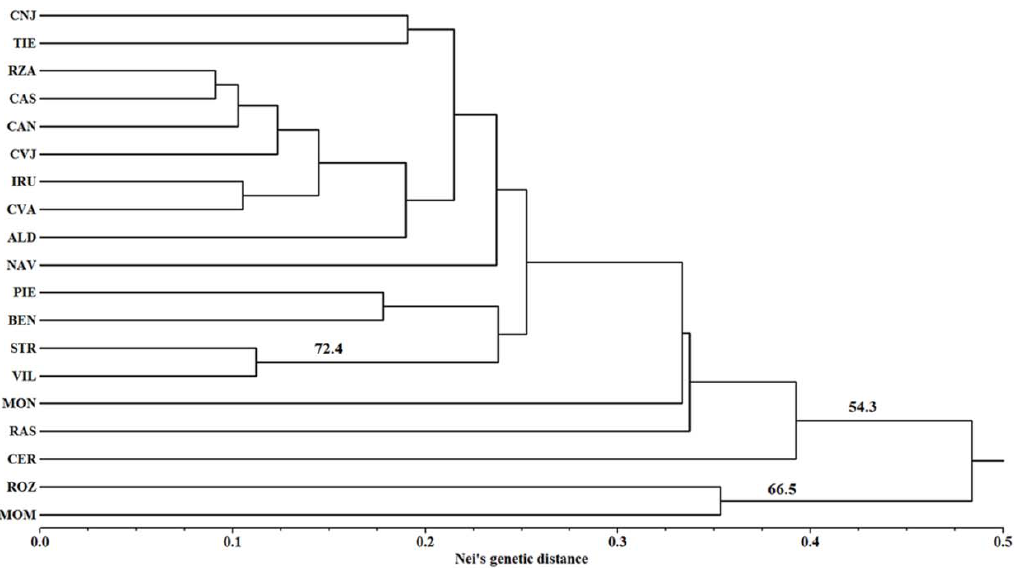
Figure 2. Unweighted pair group with arithmetic mean (UPGMA) clustering showing the relationships among the 19 Ulmus glabra populations from the Central System of the Iberian Peninsula with at least six sampled individuals (see Table 1 for codes), based on 11 microsatellite loci data using Nei’s genetic distance. The numbers at nodes are support (>50%) by bootstrap analysis (10,000 replicates).